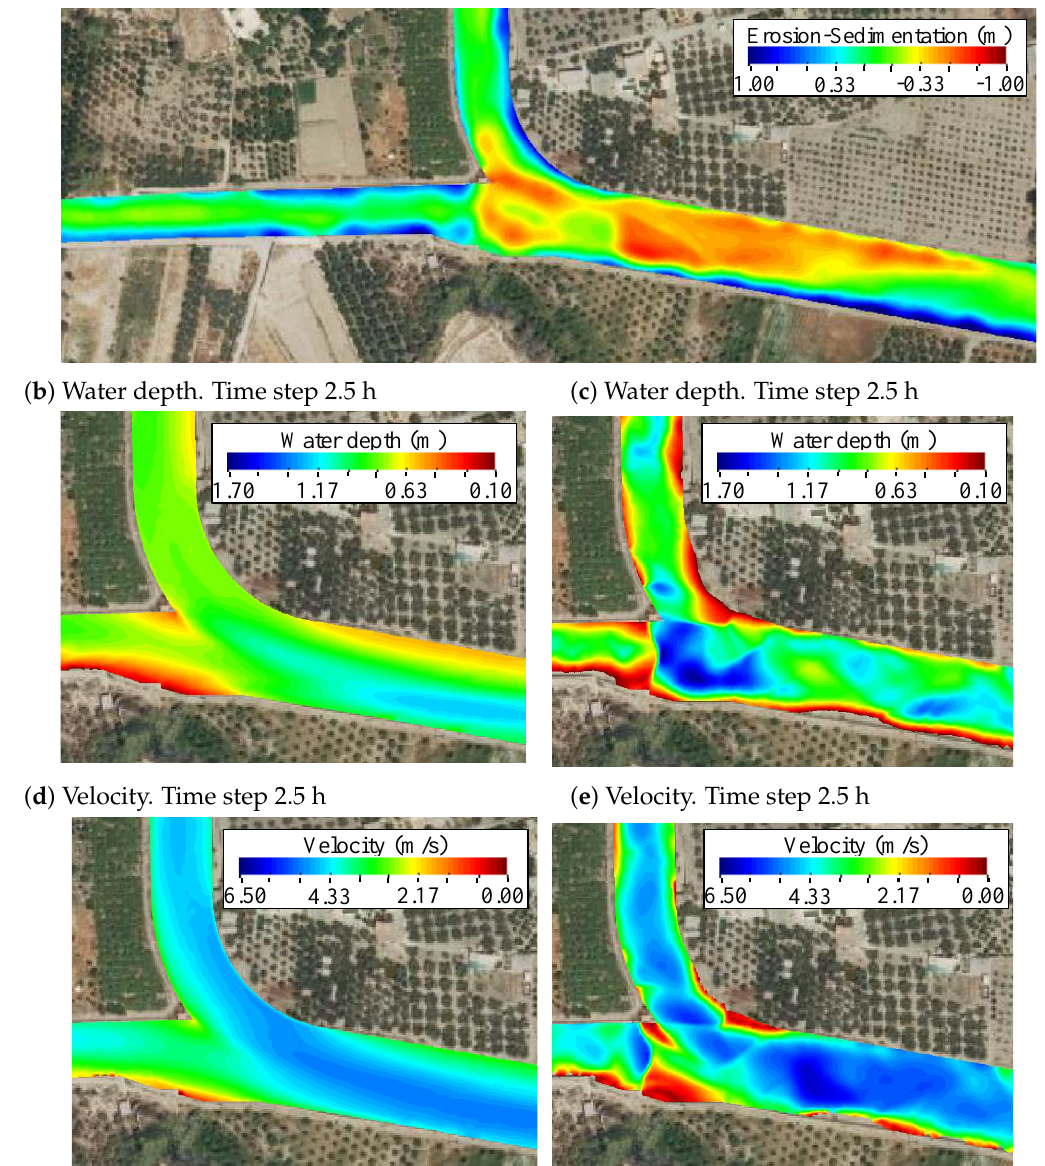
Figure 9. Effect of erosion on the flow patterns. In panel ( a ) we depict the contour plot of erosion after the 25-year flood event. Erosion is positive and sedimentation negative. Panel ( b ) depicts the water depth at time step 2.5 h for the 25-year flood event computed with bed-mobile model, whereas panel ( c ) plots the result provided by a model without bed erosion. Panel ( d ) depicts the water velocity at time step 2.5 h for the 25-year flood event computed with a bed mobile model, and panel ( e ) plots the result provided by a model without bed